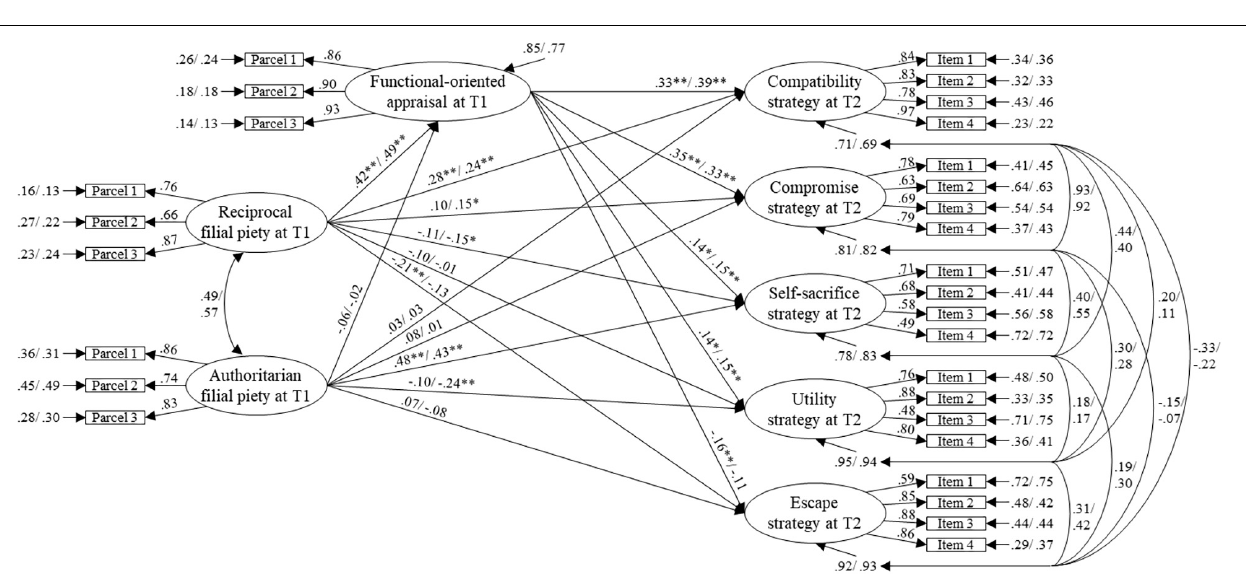
FIGURE 3 | Structural model of dual filial piety, function-oriented appraisal, and parent–adolescent conflict resolution strategy for mother–son and mother–daughter dataset in Study 2. The influence of the parental education level has been controlled in this model. All coefficients are standardized solutions; the first coefficient is from mother–son dataset ( n = 407), the second is from mother–daughter dataset ( n = 610). T1, data collected at Time 1; T2, data collected at Time 2 after a 1-year lag. * p < 0.05, ** p < 0.01.